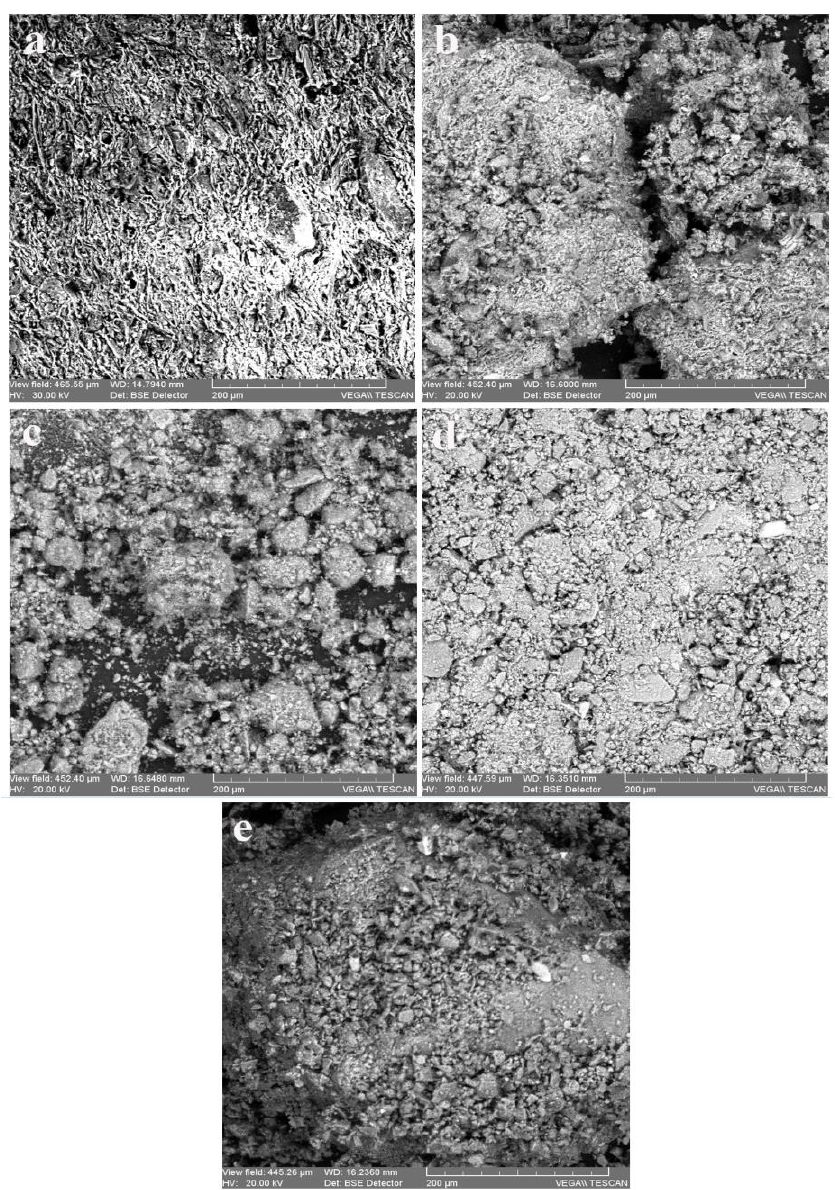
Figure 1. Scanning electron microscope images of the industrial ceramic samples: ( a ) CI a acidic ceramic; ( b ) CI sa weakly-acidic ceramic; ( c ) CI am amphoteric ceramic; ( d ) CI saHCl weakly-acidic ceramic treated with HCl 3M; ( e ) CI amHCl amphoteric ceramic treated with HCl 3M